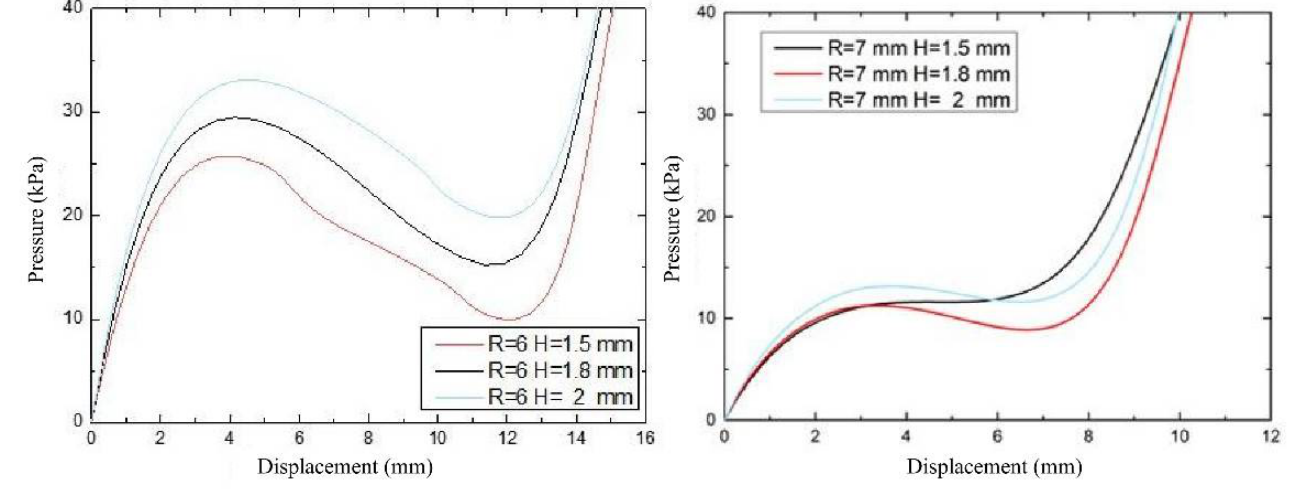
Figure 4. Relationship between spherical membrane and crown membrane load displacement under the influence of wall thickness factor .